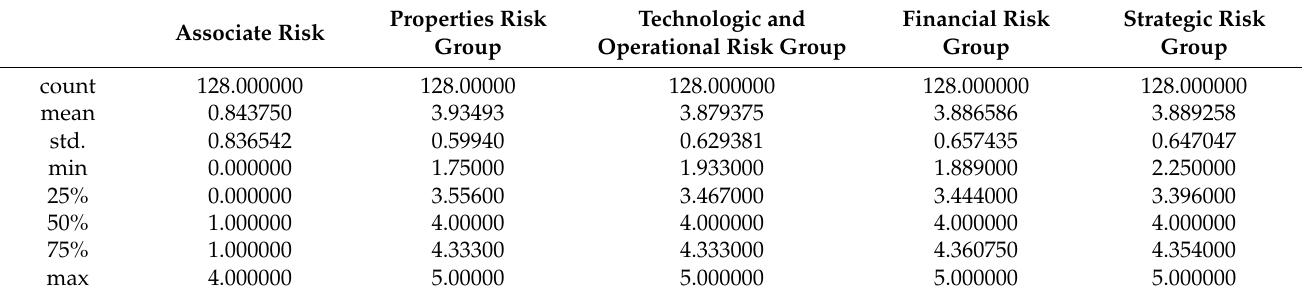
Table 2. Results of the Statistical Analysis of Risk factor